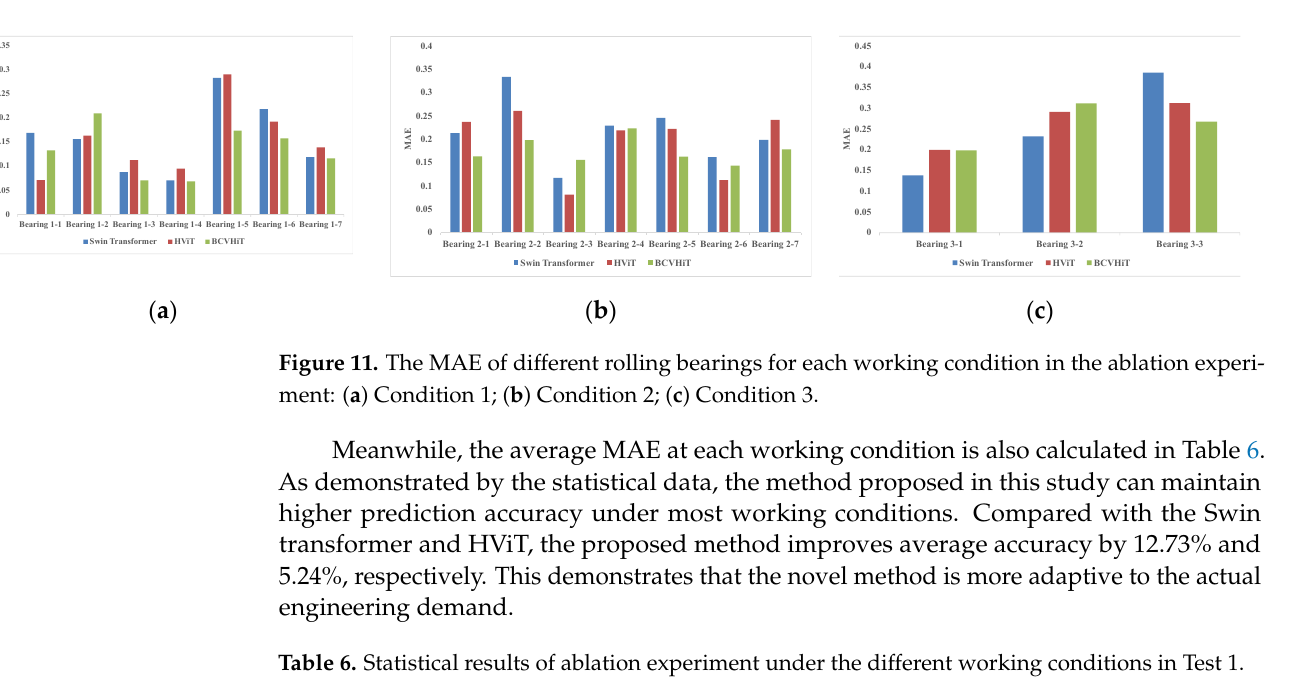
( b ) Figure 10. RUL prediction result of ablation experiment in Test 1: ( a ) Bearing 1-3; ( b ) Bearing 2-6. Statistical analysis of the experimental data was also performed, considering the in- fluence of working conditions on prediction accuracy. The MAE of different rolling bear-